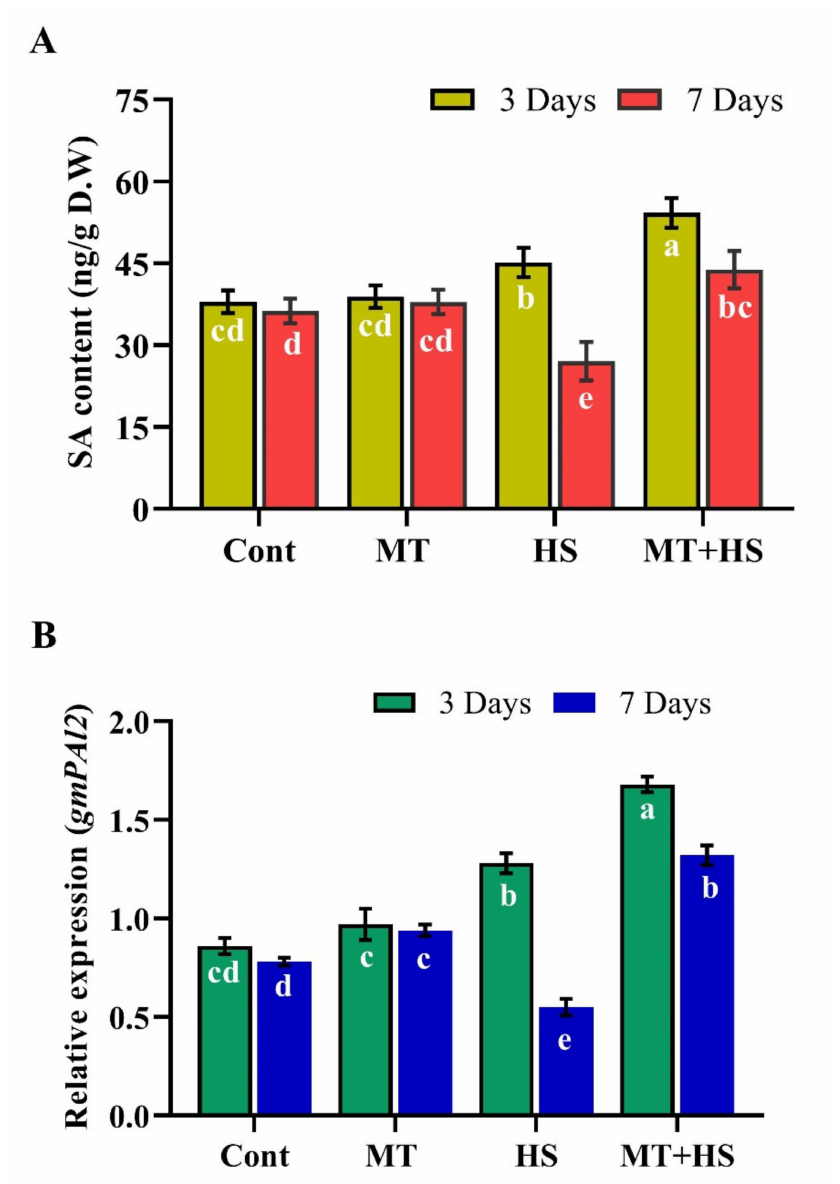
Figure 7. Effects of melatonin application with or without high temperature (42 ◦ C) on ( A ) salicylic acid (SA) and ( B ) relative expression of SA biosynthesis gene gmPAL in soybean seedling after 3 and 7 days. Each data point is the mean of three replicates. Error bars represent the standard error of the mean. Bars with different letters are significantly different from each other by Duncan’s multiple range test at p ≤